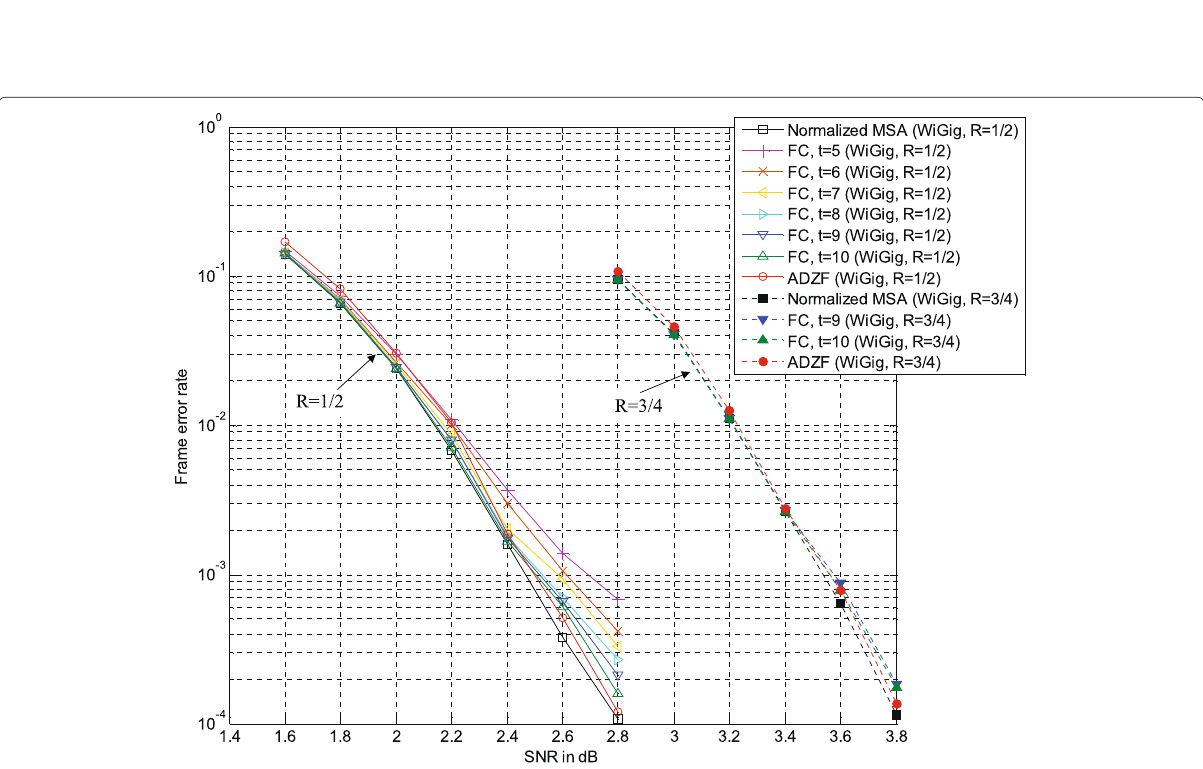
Fig. 9 Frame error rates of the normalized min-sum algorithm, conventional FC scheme, and proposed algorithm